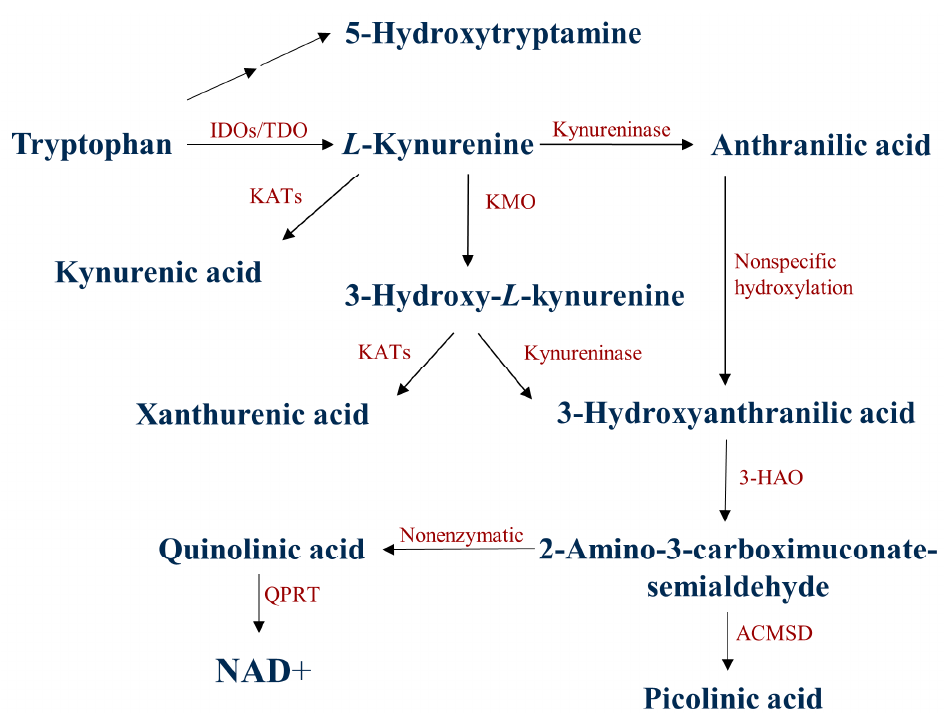
Figure 1. The kynurenine metabolic pathway of tryptophan degradation. 3-HAO: 3-hydroxyan- thranilate oxidase; ACMSD: α -amino- β -carboxymuconate-semialdehyde-decarboxylase; IDOs: in- doleamine 2,3-dioxygenases; TDO:/tryptophan 2,3-dioxygenase; KATs: kynurenine aminotrans- ferases; KMO: kynurenine 3-monooxygenase; NAD + : nicotinamide adenine dinucleotide: QPRT: quinolinate